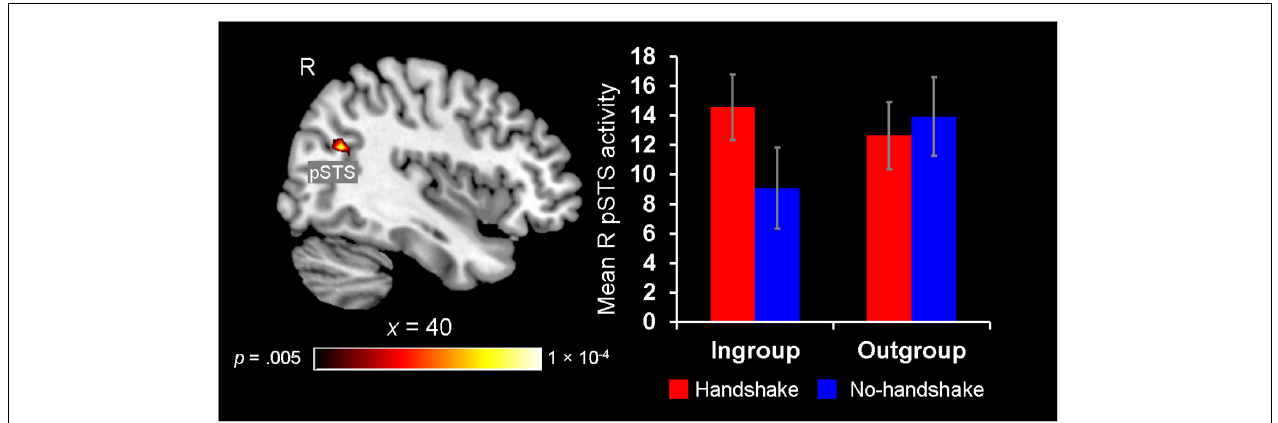
FIGURE 6 | Greater pSTS sensitivity to observing handshakes with ingroup members. A significant 2 (Handshake) × 2 (Host Race) ANOVA interaction was identified in a set of regions, including the right posterior superior temporal sulcus (pSTS) (left) . Post hoc analyses of mean parameter estimates extracted from this right pSTS cluster revealed that this region showed greater activation for observing handshakes with ingroup hosts [ t (19) = 3.00, p = 0.008], whereas its activity did not differentiate between the handshake and no-handshake conditions with outgroup hosts [ t (19) = 1.20, p = 0.25] (right) . Error bars indicate the standard error of the mean for each